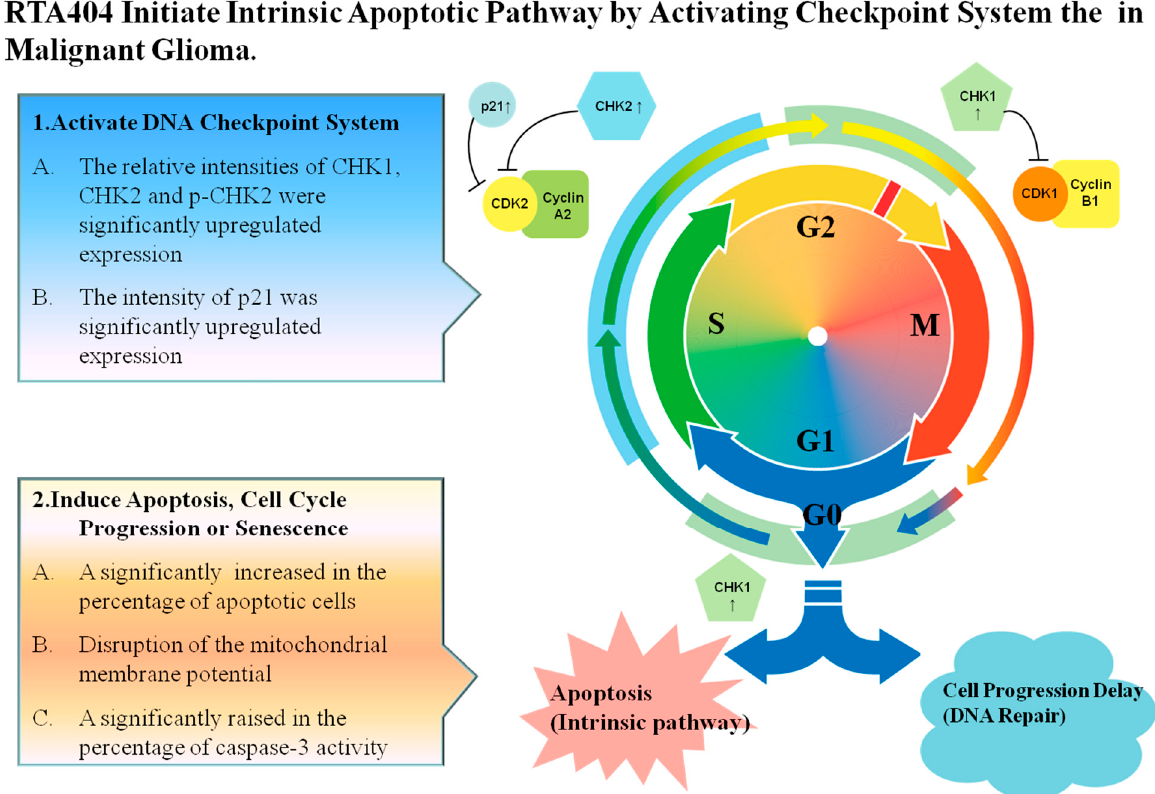
Figure 7. RTA404 induces apoptosis and cell cycle arrest in malignant glioma. RTA404, an activator of Nrf2, activates the checkpoint kinases and induces apoptosis through intrinsic apoptotic pathway in malignant glioma. G1 phase: Growth 1 phase. S phase: Synthesis phase. G2 phase: Growth 2 phase. M phase: mitosis. CDK1: Cyclin Depandant Kinase 1. CDK2: Cyclin Depandant Kinase 2. CHK1: Checkpoint Kinase 1. CHK2: Checkpoint Kinase 2.